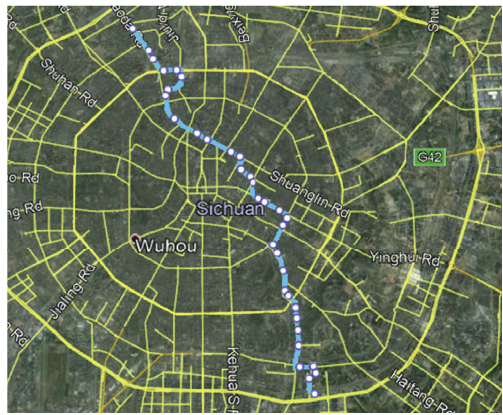
Figure 3: The existing bus stop locations of bus route no. 3 in Chengdu